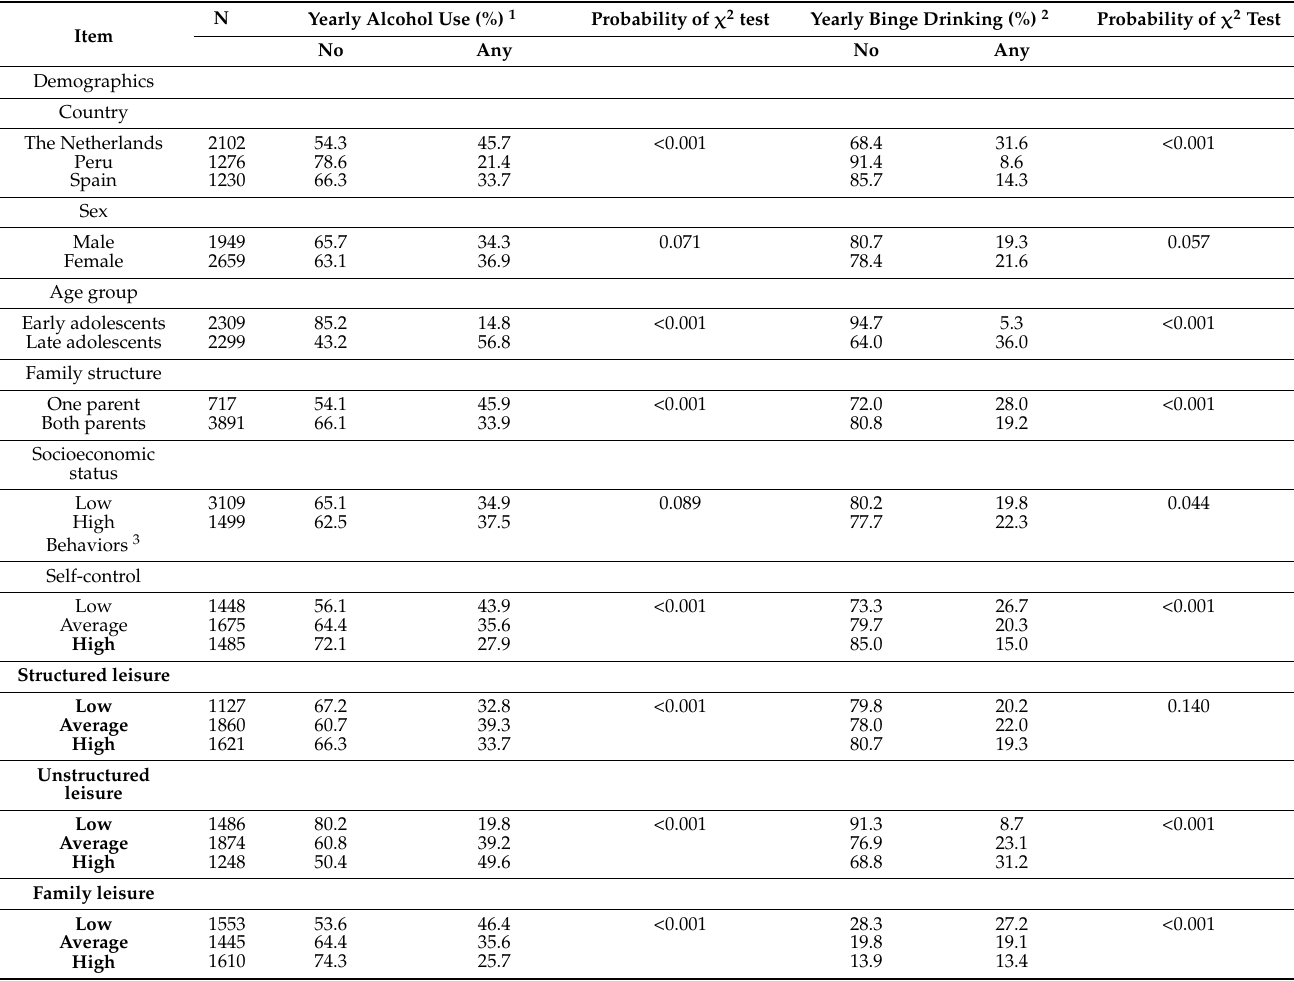
Table 3. Demographics and behaviors, by alcohol and binge drinking use. Association test ( χ 2 ) between the levels of those factors and YAU and